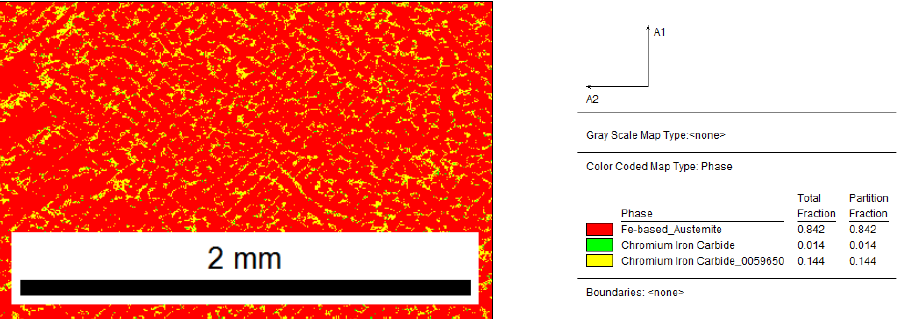
Figure 8. Inoculated sample with 0.33% Fe – Ti: distribution map of occurring phases, yellow area — M 7 C 3 , green area — M 3 C.